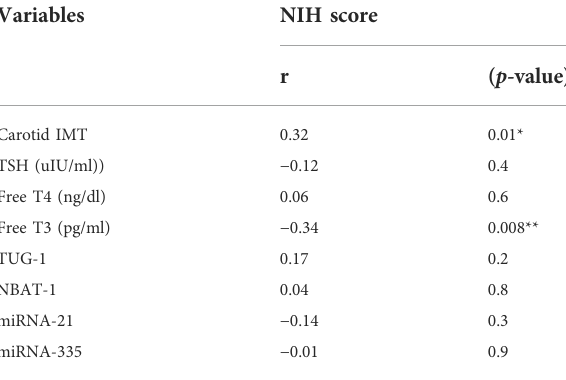
TABLE 5 Correlation between NIHSS score and study variables among